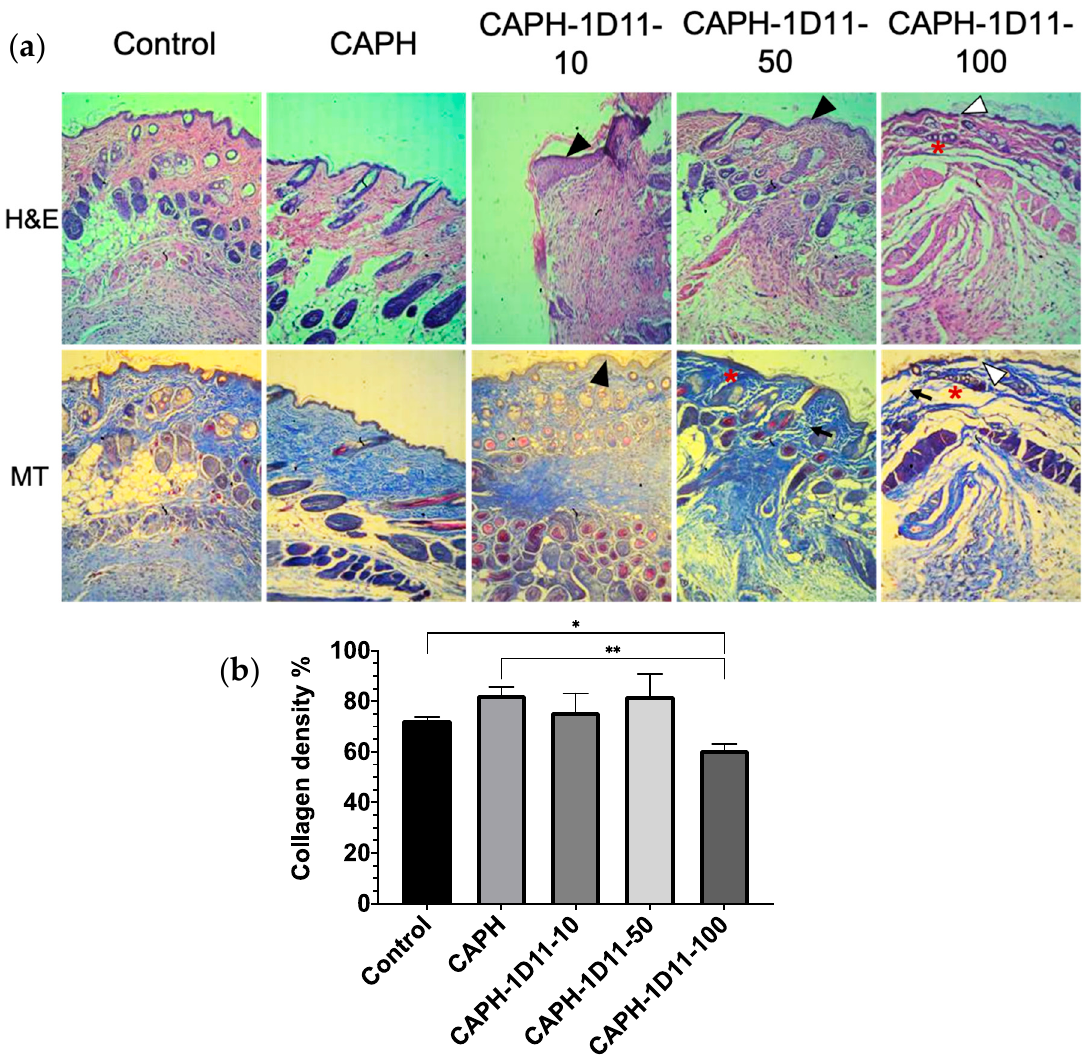
Figure 3. ( a ) Hematoxylin and eosin (H&E) and Masson’s trichrome (MT) stained microscopic sections at day 10. Two excisional wounds were created on each dorsal side before Ca-alginate-PEGMA hydrogels (CAPH), or CAPH loaded with 10, 50, and 100 μ g anti-TGF- β antibody (CAPH-1D11-10, CAPH-1D11-50, and CAPH-1D11-100, respectively) were applied to the right side. The wound on the left side received only standard disinfection treatment (Control). Micrographs of stained tissues were captured under 100X magnification. Application of CAPH-1D11-10 produced a tighter epidermis than other treatments (black arrowheads), while treatment with CAPH-1D11-50 produced irregular epidermal layers. Application of CAPH-1D11-100 produced epidermis and collagen fragmentation (white arrowheads and black arrows, respectively). Edematous zones (asterisks) are also indicated in CAPH-1D11-50 and CAPH-1D11-100 treated wounds. ( b ) Quantitative analysis of collagen density from blue channel of MT-stained sections. CAPH-1D11-100 treated wounds exhibit the lowest collagen density, presented as a mean ± SEM. n = 5/group. Significance is denoted as * p < 0.05 and ** p <